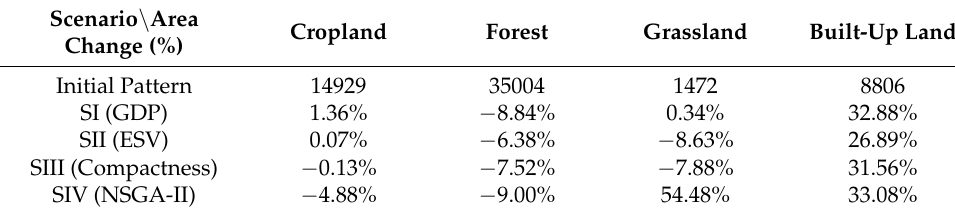
Table 5. The Area change of land use under different scenarios.